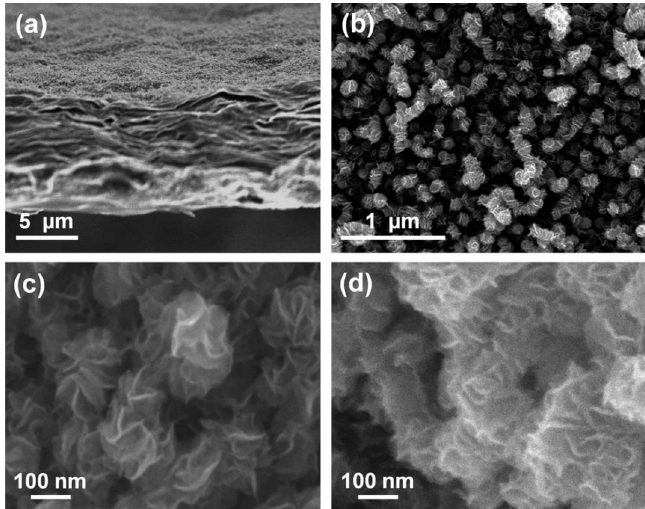
Figure 61. SEM images of ( a ) the cross-section and ( b ) the top view of MoS 2 NF/rGO. Highly magnified SEM images of the top view of ( c ) MoS 2 NF/rGO and ( d ) MoS 2 AG/rGO